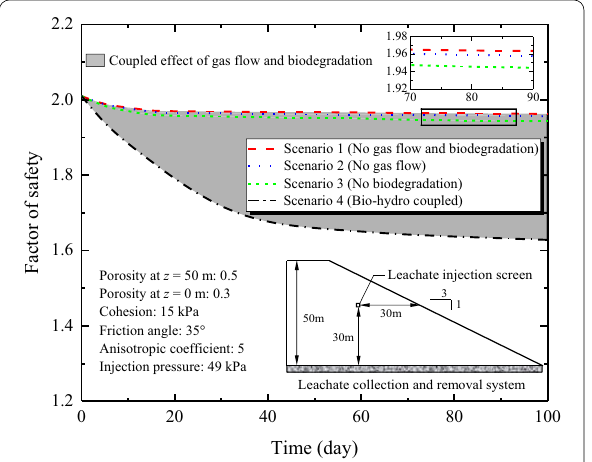
Fig. 6 Variations of FS with time for different scenarios under leachate recirculation with horizontal trench